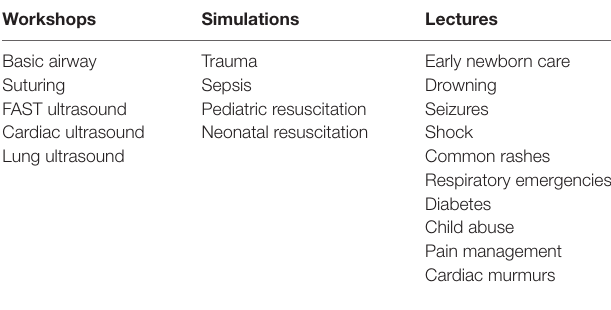
taBle 1 | Curriculum content and delivery.